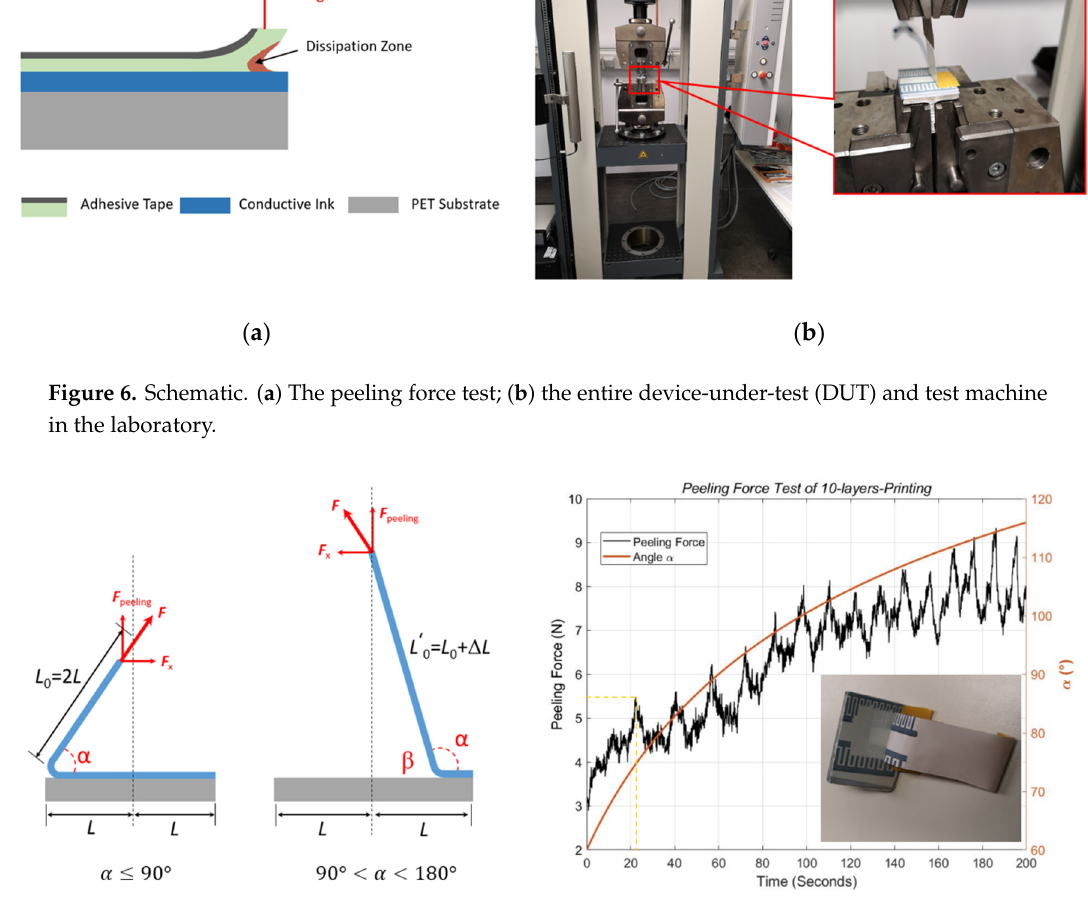
Figure 6. Schematic. ( a ) The peeling force test; ( b ) the entire device-under-test (DUT) and test machine in the laboratory.